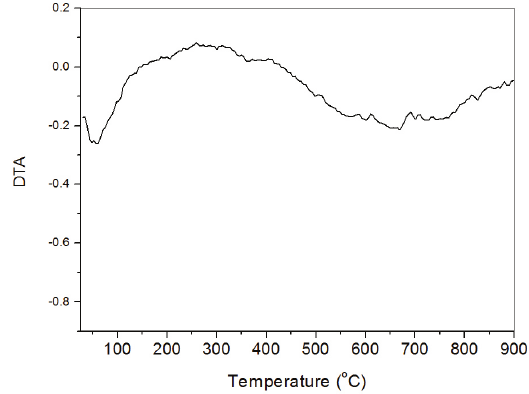
Figure 4. DTA curve of the synthesized ZnAl